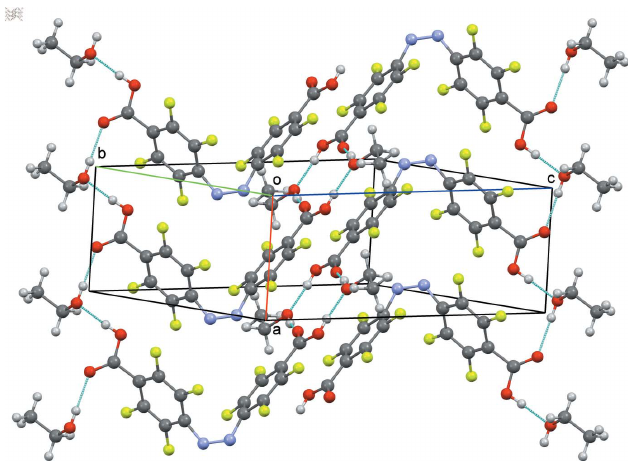
Figure 3 Partial view of the packing of (I), showing the hydrogen-bonding interactions (dotted lines). Hanging hydrogen bonds were omitted for